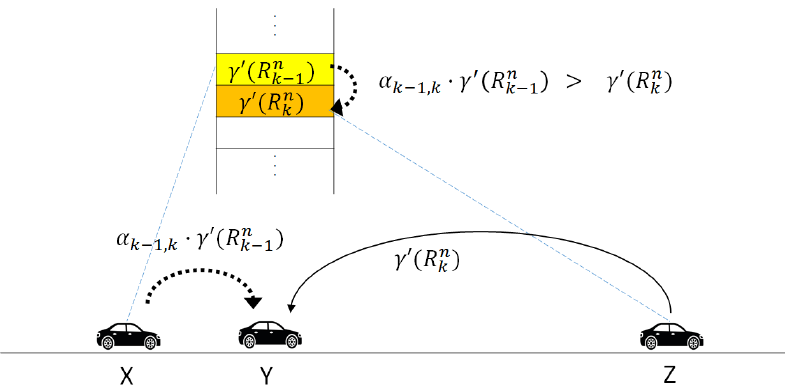
Figure 4. In-band emission from a much closer vehicle.